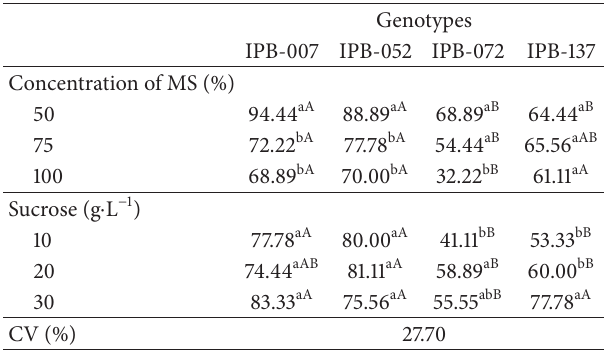
Table 6: Survival of sweet potato plants at 270 days of in vitro conservation under 18 ∘ C, depending on genotype and the variations of MS salts and sucrose concentration.